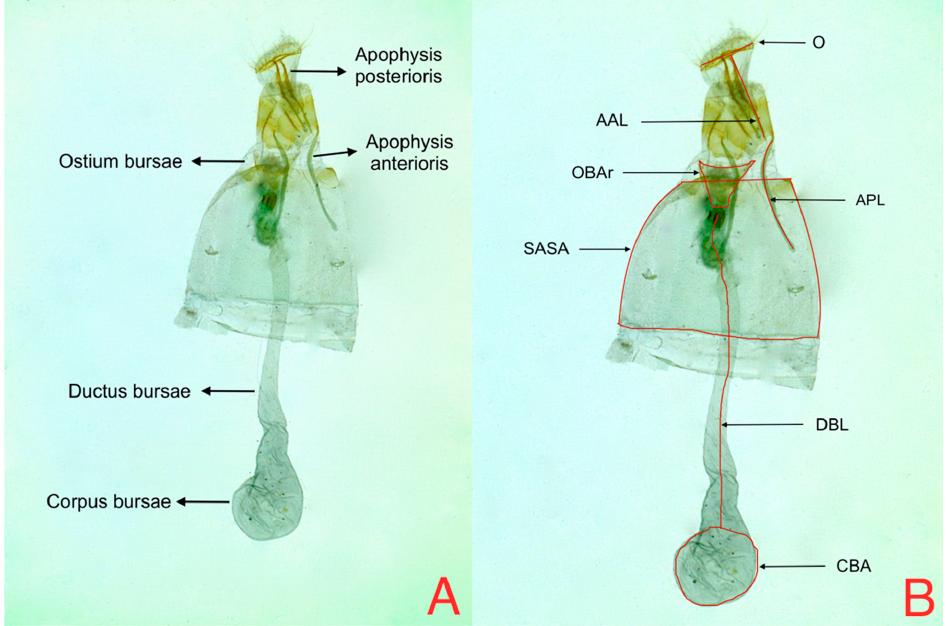
Figure 3. Female genitalia ( A ) Anatomic structures and ( B ) Measures: AAL = apophysis anterioris length; APL = apophysis posterioris length; SASA = seventh abdominal segment area; DBL = ductus bursae length; CBA = corpus bursae area; OBAr = ostium bursae area.